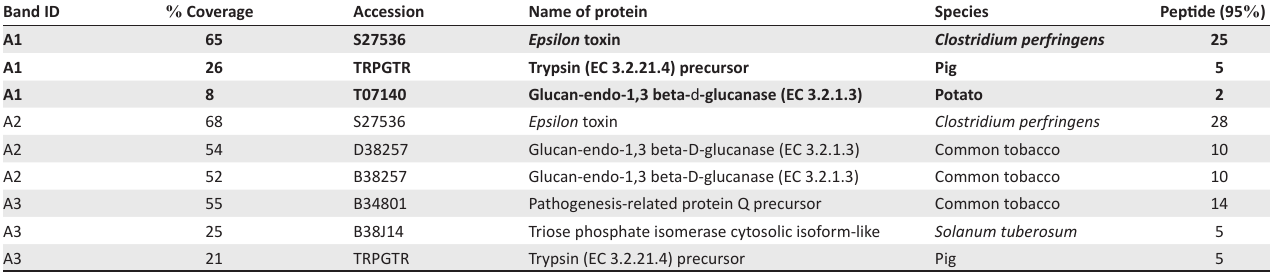
TABLE 1: Sequencing data for the putative r-Etx protein bands from SDS–PAGE by mass spectrometry peptide finger printing. Band